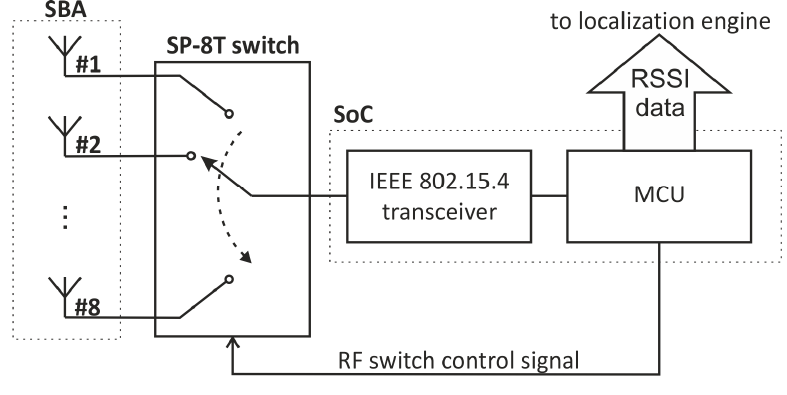
Figure 1. Anchor system architecture.